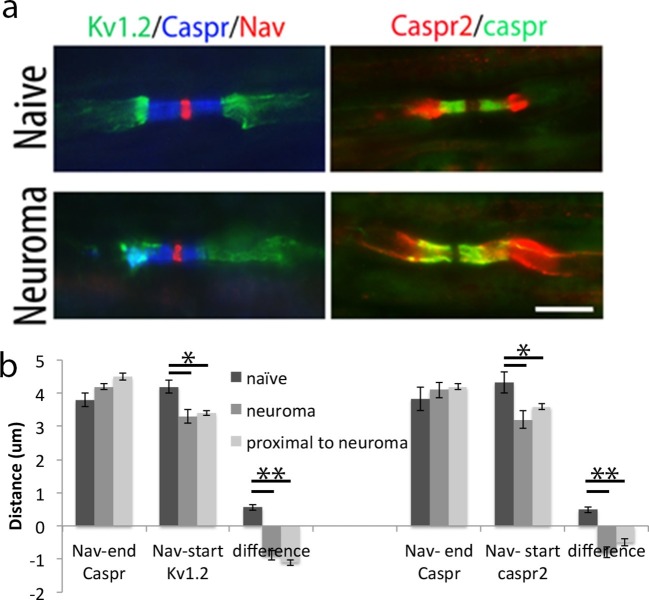
Relocalization ok Kv1.2 and caspr2 at 7 days after neuroma.(a) Representative longitudinal sections of nerves immuno-stained with Kv1.2 in green, a panNav antibody in red (to identify the node) and caspr in blue (to identify the paranode). Kv1.2 is expressed in the juxtaparanode in naïve nerves but it also co-localized with caspr staining at 7 days after injury. Representative longitudinal sections of nerves immuno-stained with caspr2 in green and caspr in red. Caspr2 is confined to the juxtaparanode in naïve nerve but co-localized with caspr at 7 days after injury. (b) We quantified the distance between the sodium channel staining (Nav) and the end of the caspr staining, distance between the sodium channel staining (Nav) and the start of the Kv1.2/1caspr2 staining, and difference between these distances. A negative value represents an overlap of paranodal and juxtaparanodal proteins. Note that he distance between the sodium channel staining (Nav) and the end of the caspr staining remains unchanged after nerve injury, while the distance between the sodium channel staining (Nav) and the start of the Kv1.2/caspr2 staining is significantly shortened after nerve injury, indicating co-localization of Kv1.2 and caspr2 with caspr (n = 5 animals, 20–41 nodes per animal), p<0.001, one way ANOVA Tukey post hoc tests). We analyzed uninjured (naïve) nerve, nerve at the site of the neuroma (day 7), and nerve 1 cm proximal to the neuroma (day 7). The effect on Kv1.2 re-localization remains the same at the site far from the neuroma. The effect on caspr2 re-localization is slightly smaller at the site 1 cm proximal to the neuroma compared with the neuroma site, but it is still significantly different from the naïve **p<0.001, *p<0.05, PRN = paranode, JXP = juxtaparanode. Scale bars = 5 μm.DOI:
http://dx.doi.org/10.7554/eLife.12661.00710.7554/eLife.12661.008Figure 3—source data 1.Source data for Figure 3.